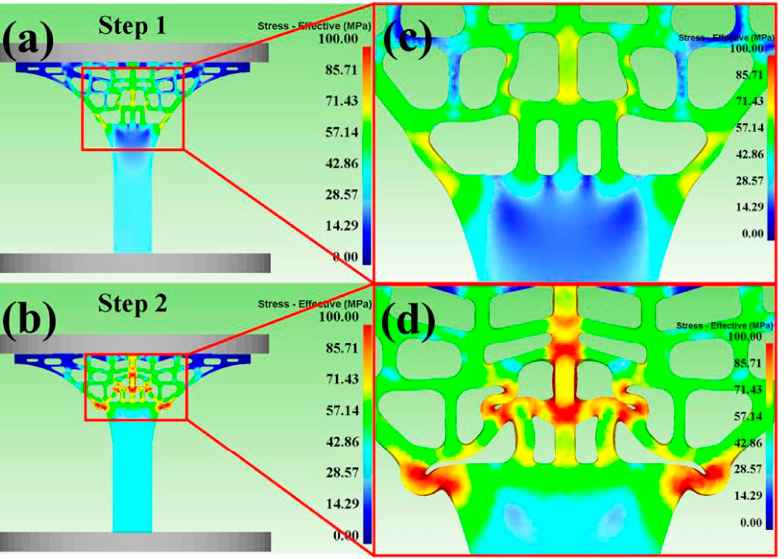
Figure 5. Predicted effective stress distribution during compression at the different steps: ( a , b ) Stress-effective at Step 1 and Step 2; ( c , d ) the enlarged view.